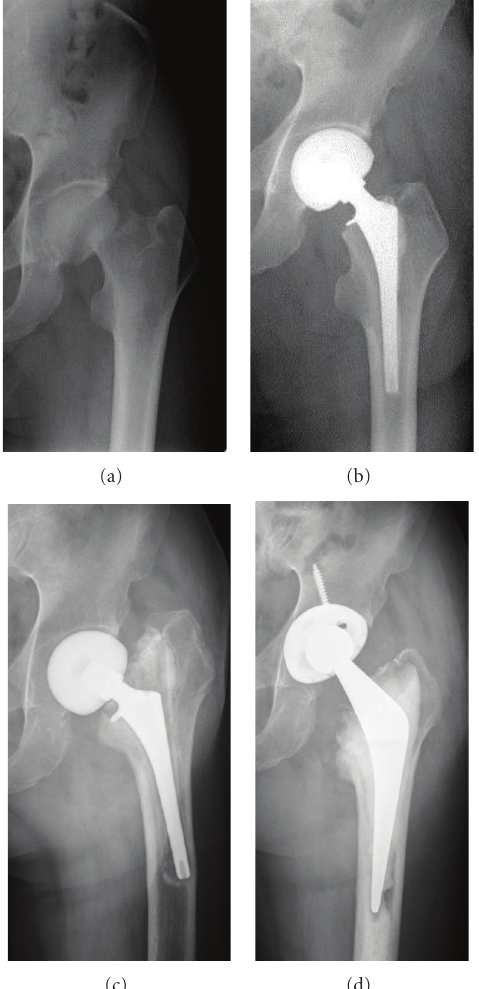
Figure 1: Radiographical findings, (a) before operation of femoral head replacement, (b) after operation of femoral head replacement, (c) 1 week after operation of femoral head replacement.